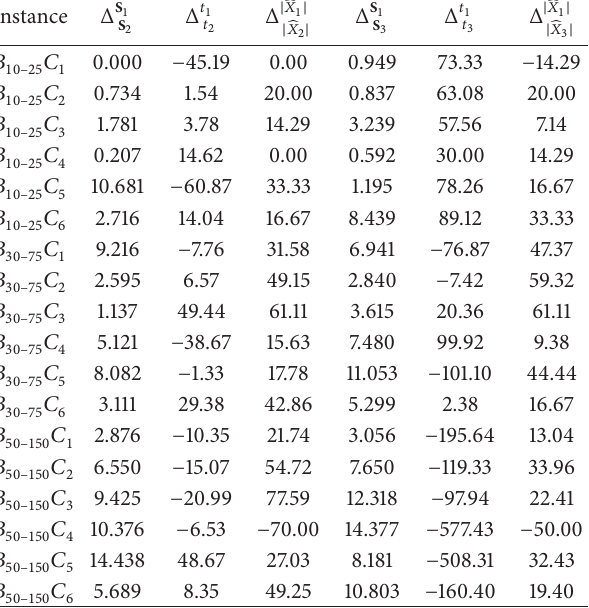
Table 6: Comparison among our BOCA